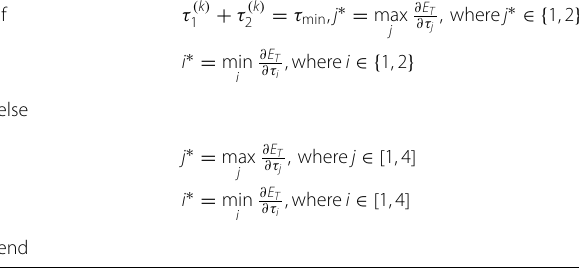
Table 2 The direction finding procedure for updating p